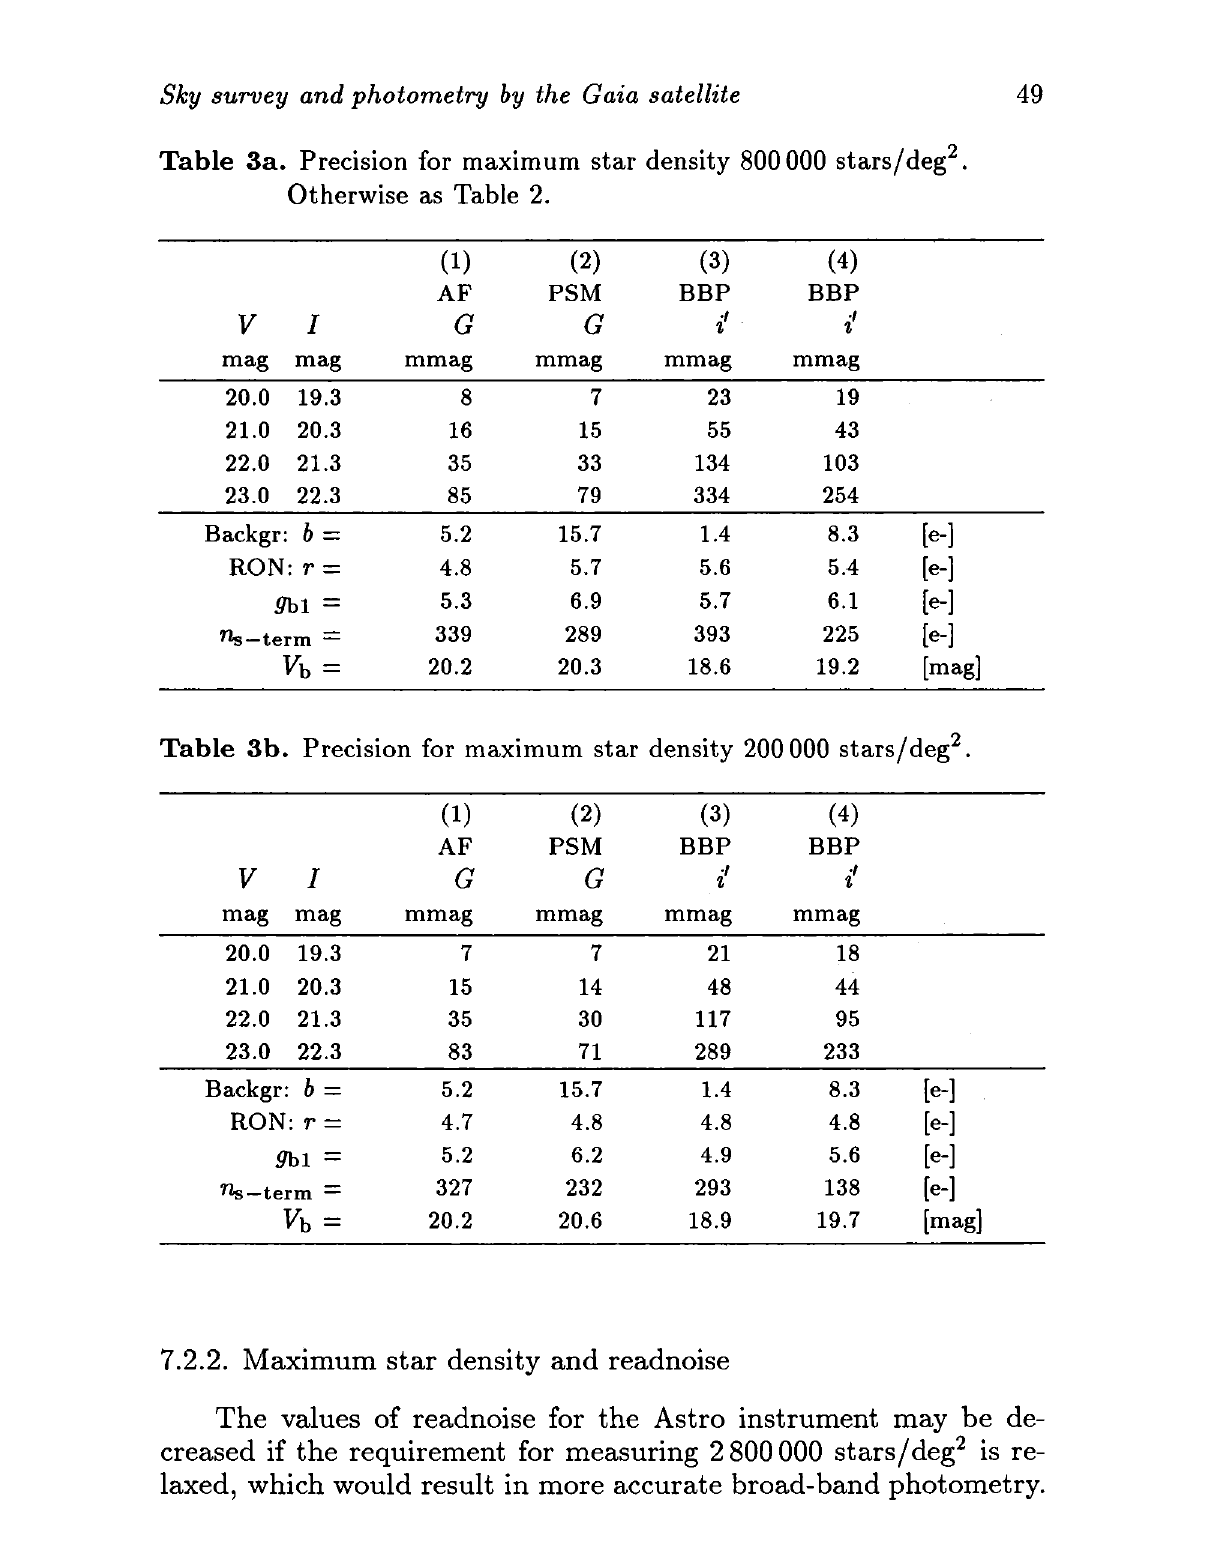
Table 3a. Precision for maximum star density 800000 stars/deg 2 .